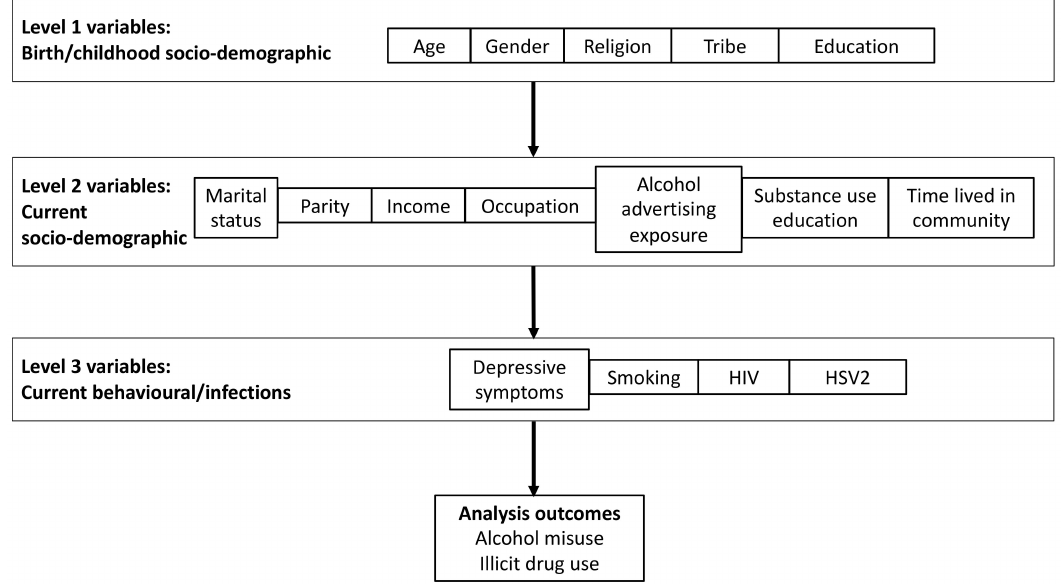
Figure 1. Conceptual framework for determinants of alcohol misuse and illicit drug use. HIV-Human Immunodeficiency Virus, HSV2-herpes Simplex